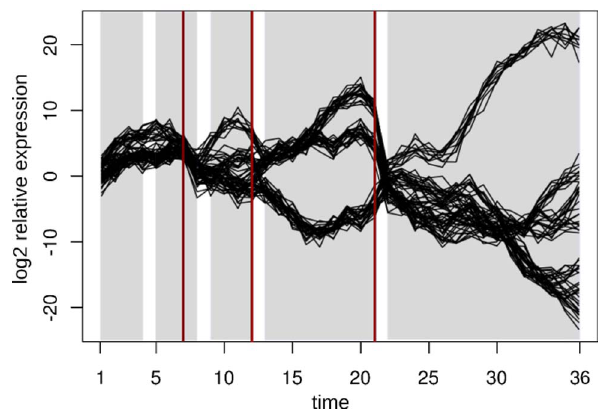
Figure 4. Illustration of the segmentation for synthetic data with relative density as network property. The resulting partitions are highlighted in light grey and the simulated segmentation points are marked with red bars.